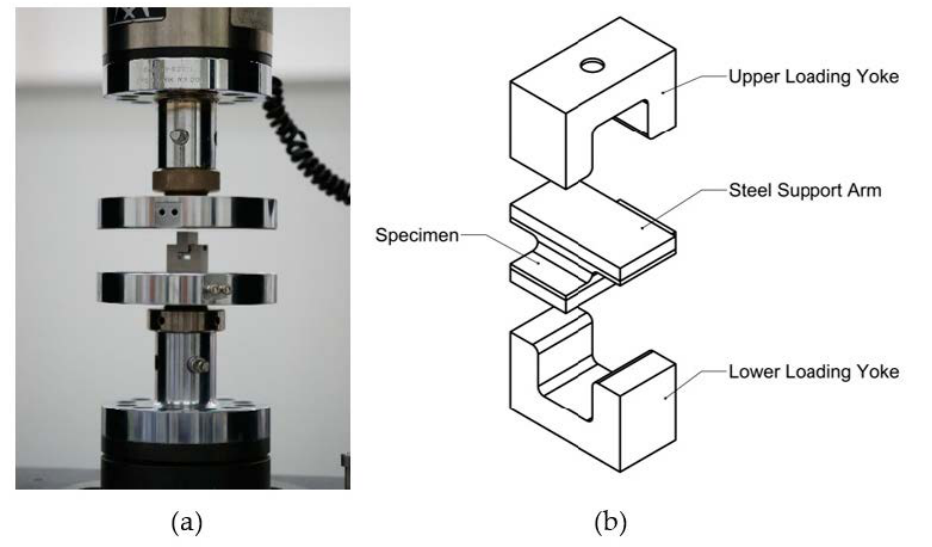
Figure 5. Test set up for cruciform testing: ( a ) image of test set-up and ( b ) exploded diagram. Cylindrical punch-out tests were undertaken based on the method described in